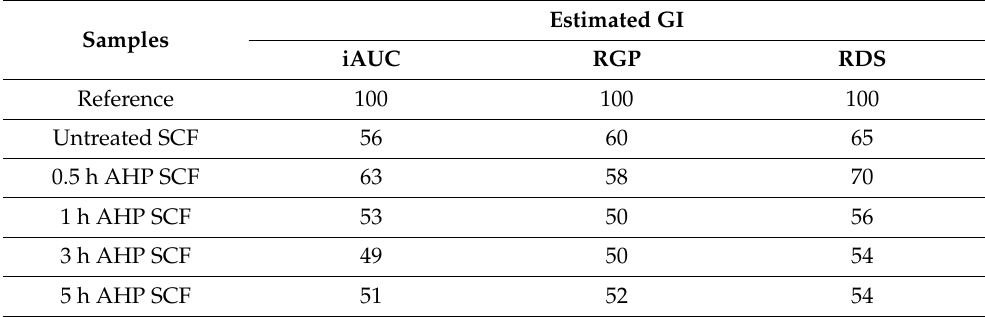
Table 4. Estimated glycemic index (GI) values of bread samples with no SCF incorporated (reference), incorporated with 5% untreated SCF, and 0.5 to 5 h AHP SCF based on fresh weight basis.